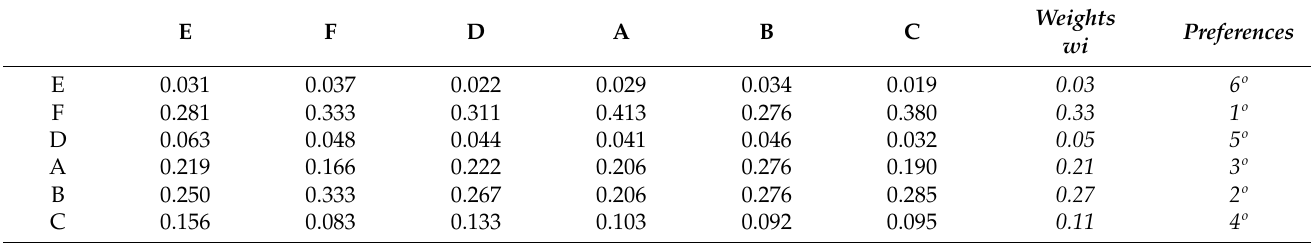
Table 5. Normalised comparison matrix for the project evaluation